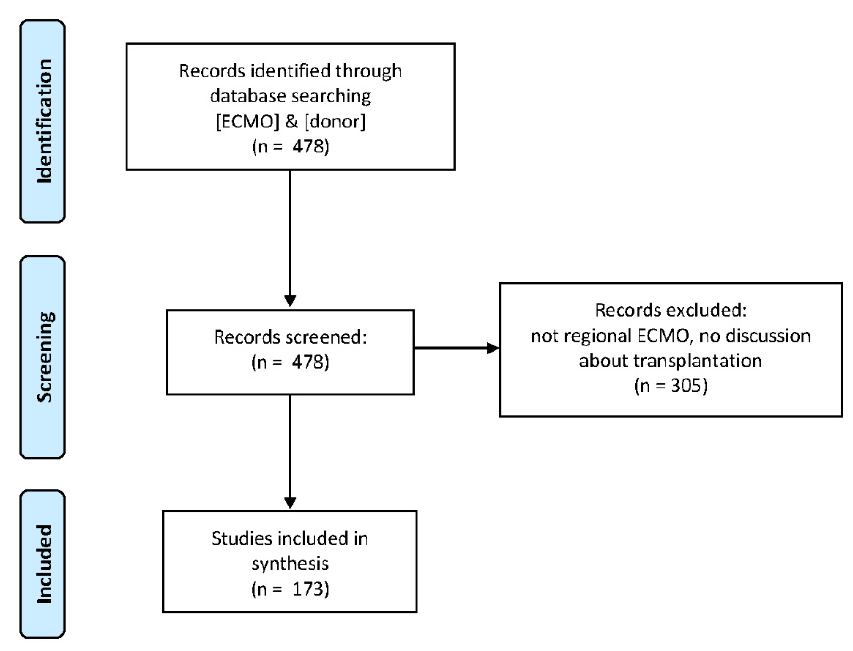
Figure 2. Flowchart showing study identification, screening, and inclusion.